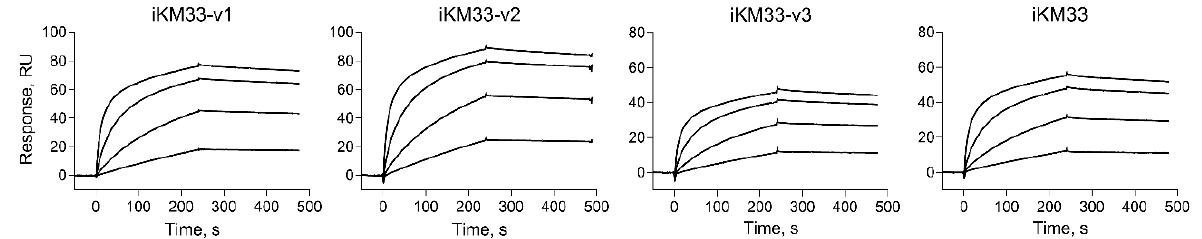
Figure 2. Binding of FVIII to iKM33 variants by SPR. Each scFv variant was covalently immobilized on a sensor chip. FVIII was injected over the chip at concentrations of 3.125 nM, 12.5 nM, 50 nM, and 200 nM. Resulting K D values were calculated using the 1:1 binding model.